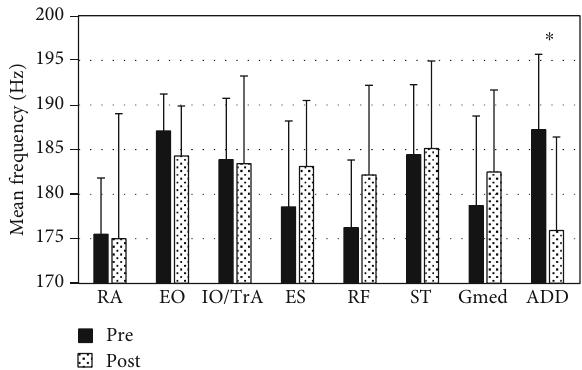
Figure 1: Comparison of the mean frequency before and after fatigue. RA: rectus abdominis; EO: external oblique; IO/TrA: internal oblique/transversus abdominis; ES: erector spinae; RF: rectus femoris; ST: semitendinosus; Gmed: gluteus medius; ADD: adductor muscle. ∗ Signi fi cant di ff erence ( P < 0 : 05